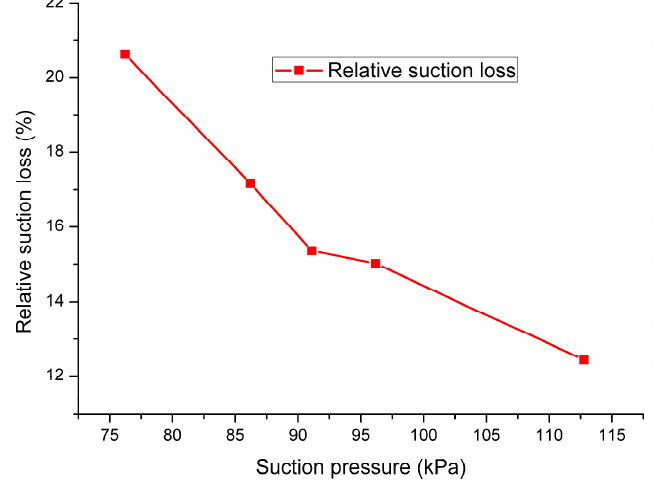
Figure 9. Suction loss under different suction pressures.